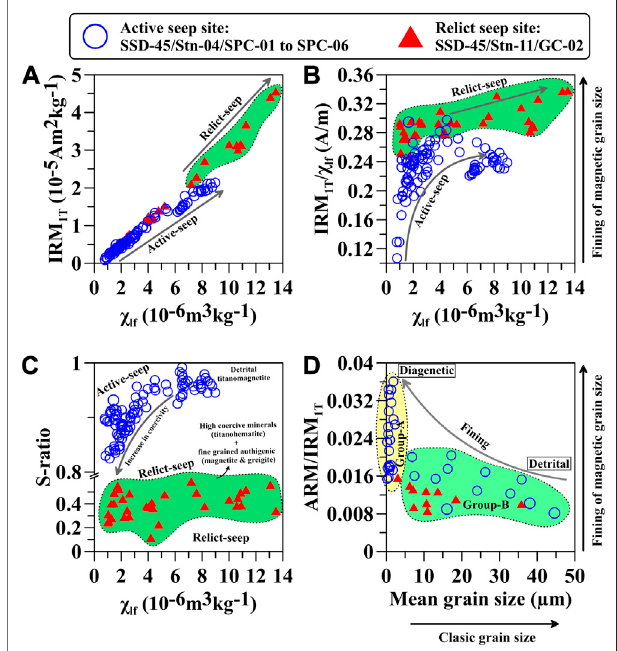
FIGURE9|(A – F) Grainsizedistributionandmagneticsusceptibilitydata of all spade (SPC-01 to SPC-06) sediment cores retrieved from active methane seep site SSD-45/Stn-4. Depths of carbonate occurrence are highlightedinsolidredarrows(vertical).Thedepthofgreigiteoccurrence is marked by “ G ” . Sediment magnetic zones (Z-I, Z-II) in each pro fi le are marked.